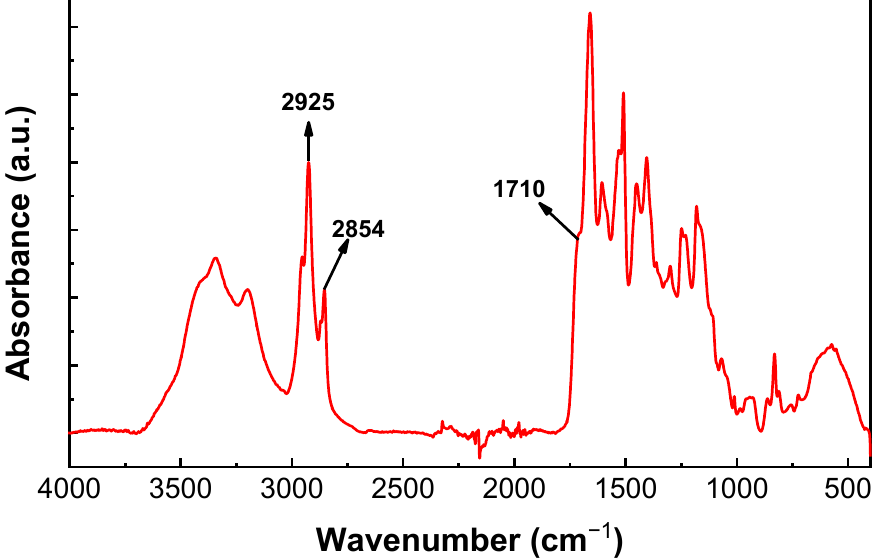
Figure 1. The FTIR spectrum of metallized acrylic.